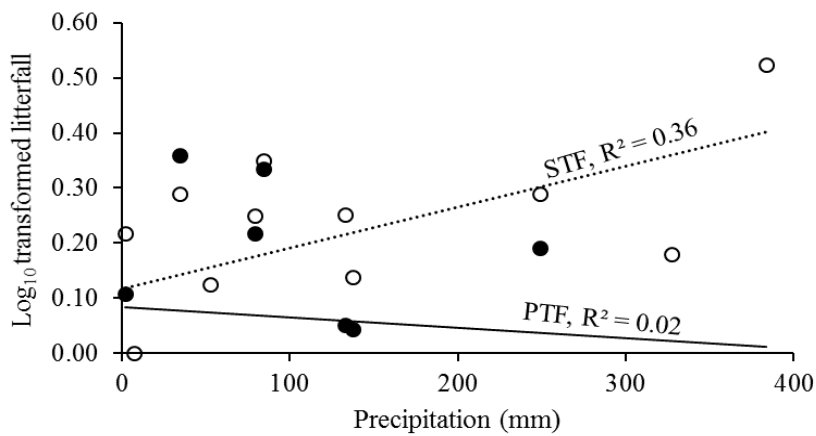
Table 2. Correlatio ns (Pearson’s) between climate (PPT and TEMP) and leaf litter; and soil nutrient pools from the study sites.